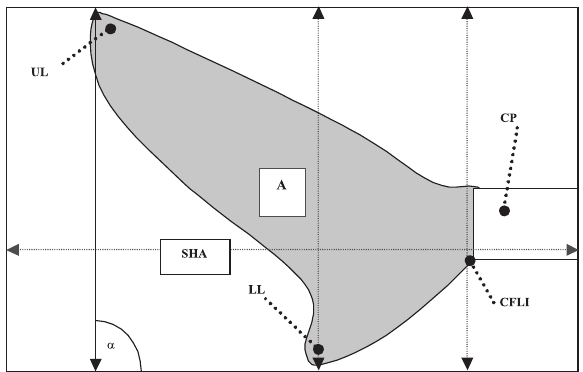
Fig . 2. – Schematic representation of the sagittal section of the het- erocercal caudal fin and morphometric measurements of the caudal fin span ( S ) and caudal fin area ( A , in grey zone) digitally collected. α =90: angle between S and shark horizontal axis. Sha: shark hori- zontal axis; cP: caudal peduncle; cFli: caudal fin lower insertion; ll: lower lobe; Ul: upper